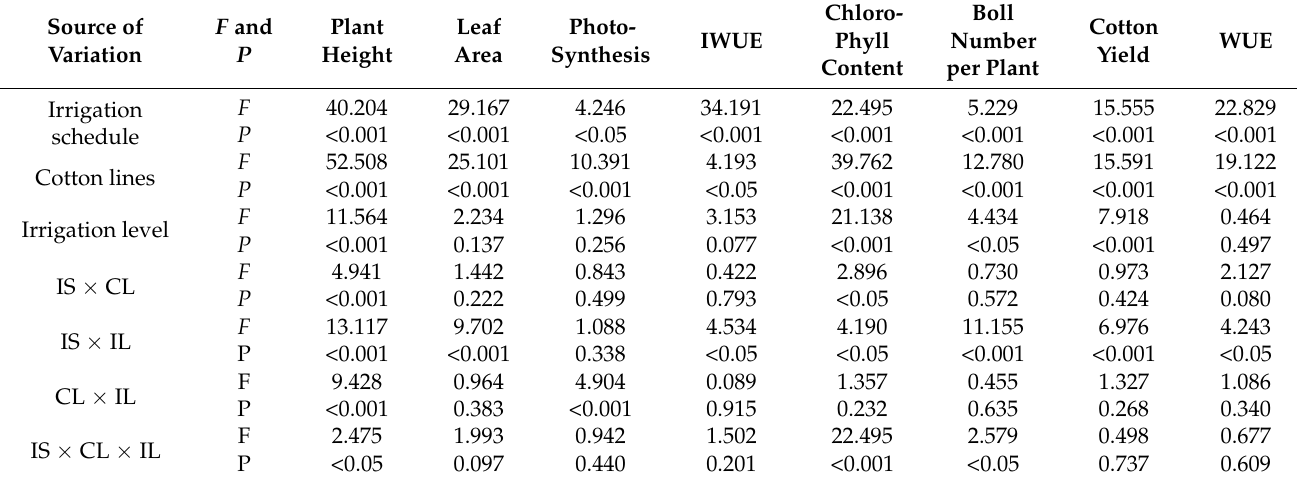
Table 3. The results of the linear mixed effects model testing the effects of irrigation scheduling and levels, and cotton lines on cotton phenotype, physiology, and yield. Two and three-way interactions are shown in the model. The source of variation from 3 years of data is analysed via mixed